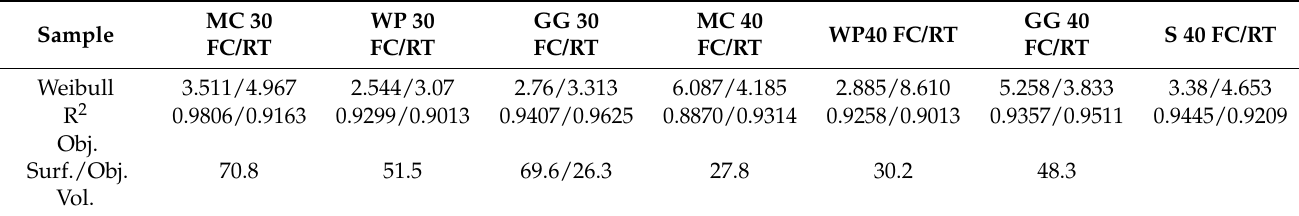
Table 4. Weibull-modulus m (Visual-XSel 14.0) and object-surface-to-object-volume ratio of investigated samples.